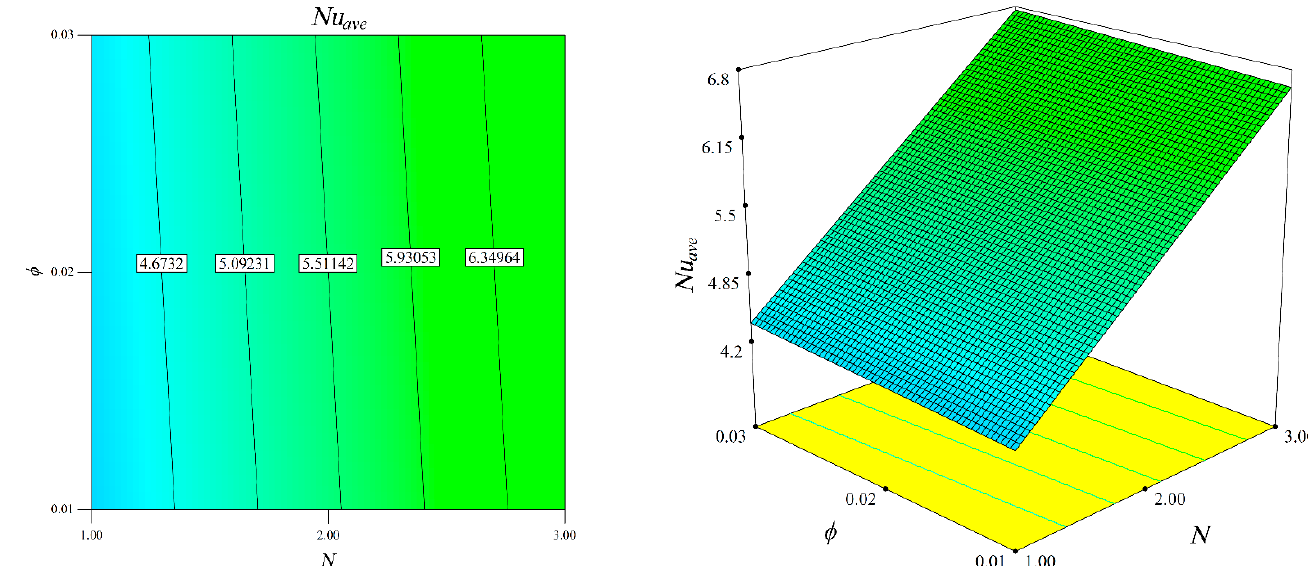
Figure 4. ( a ) Local Nusselt (Nu) numbers for different values of volume fractions of the nanofluid and radiation parameters when Ra = 10 4 , Ha = 25, and m = 3, ( b ) average Nu number for different values of volume fractions of the nanofluid and radiation parameters.